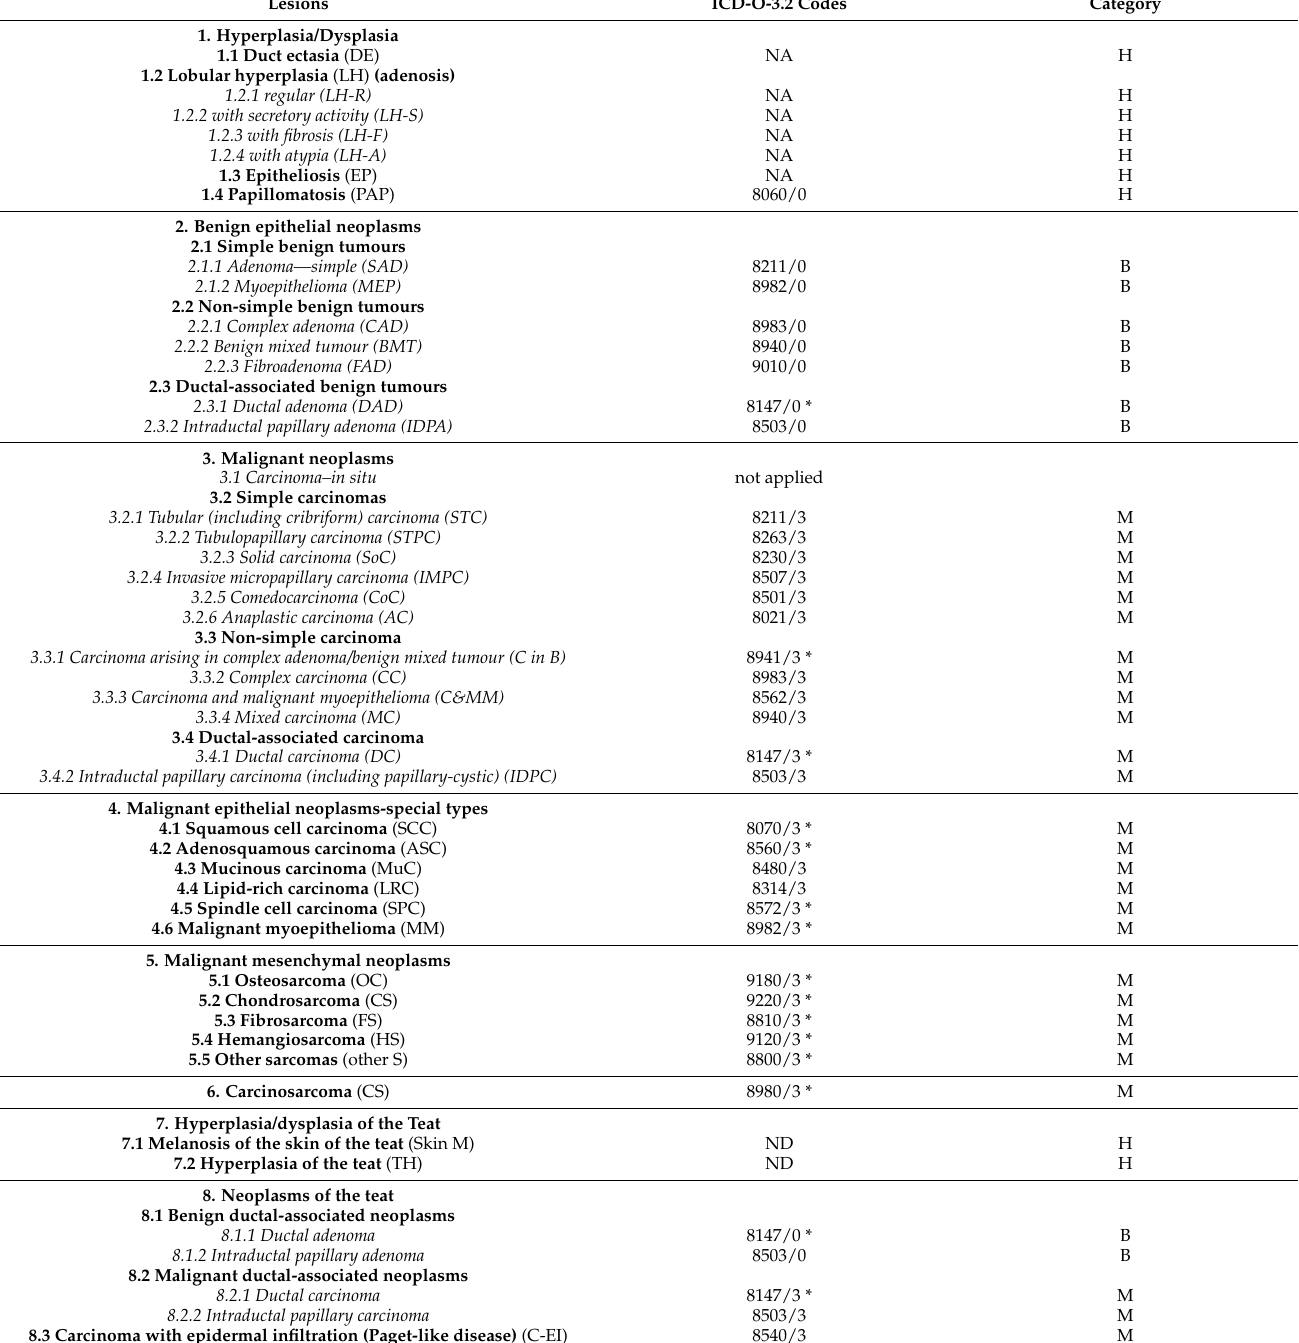
Table 2. Davis Thomson Foundation classification of canine mammary tumours [7], associated ICD-O-3.2 codes [64], and applied category of lesion. Main categories are indicated in bold and subcategories in